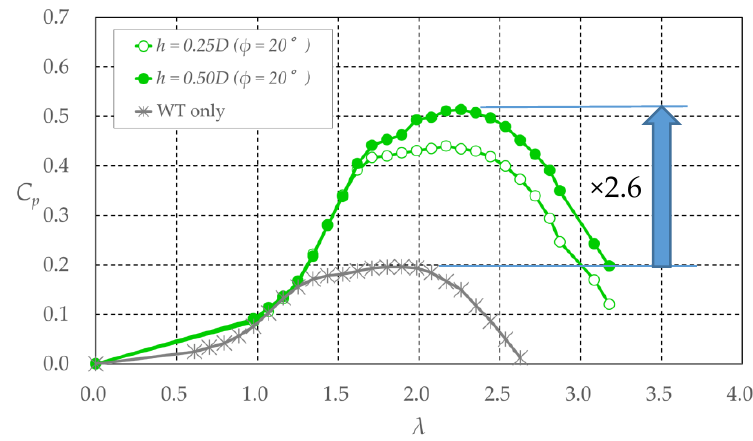
Figure 3. Power coefficient C p of wind turbines with and without a wind lens vs. tip speed ratio λ (diffuser length: L = 1.14 D m). Refer to Figure 2 for h , D , L , and φ.